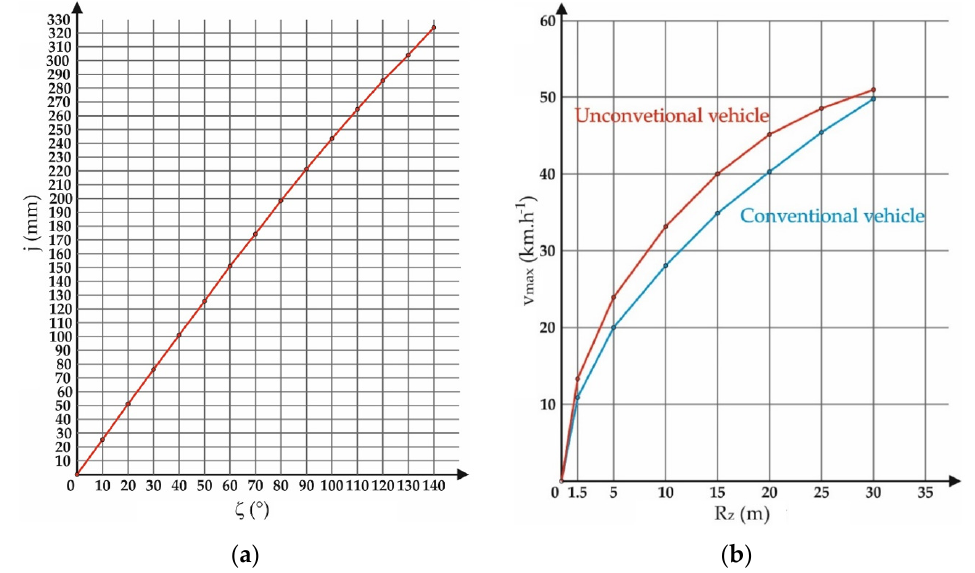
Figure 16. ( a ) Front wheel deflection characteristic j as a function of steering wheel angle ζ ; ( b ) graph of the dependence of the maximum theoretical riding speed v max on radius of a corner R z .